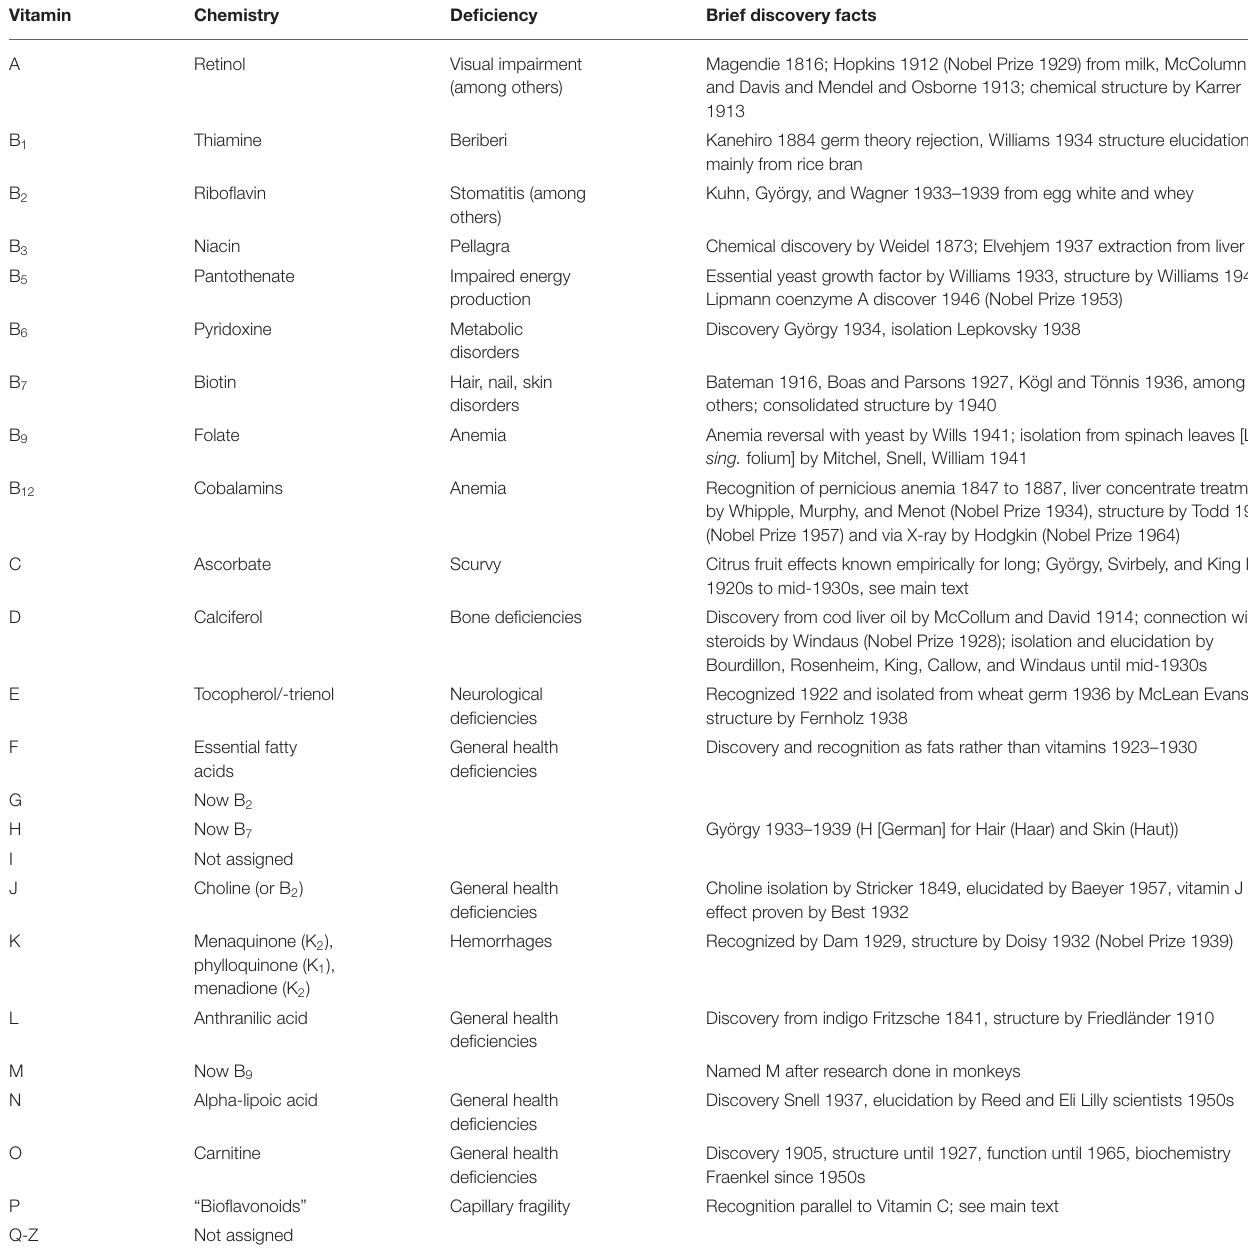
TABLE 1 | The alphabet of vitamins, their chemical description, deficiency conditions or diseases, and basic discovery facts.